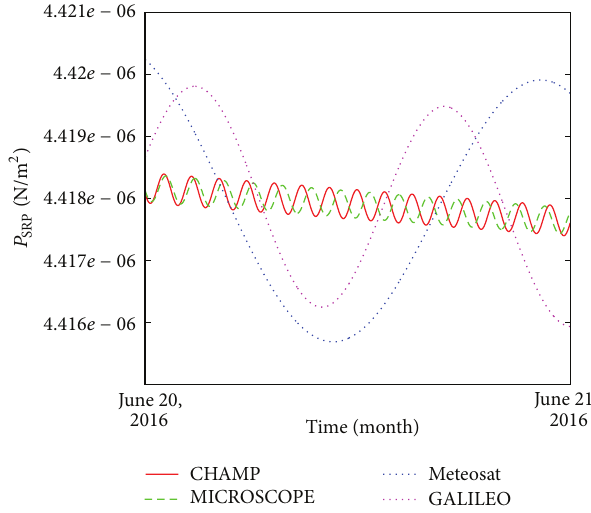
Figure 2: Resulting SRP for selected satellite missions. The variation over one day is